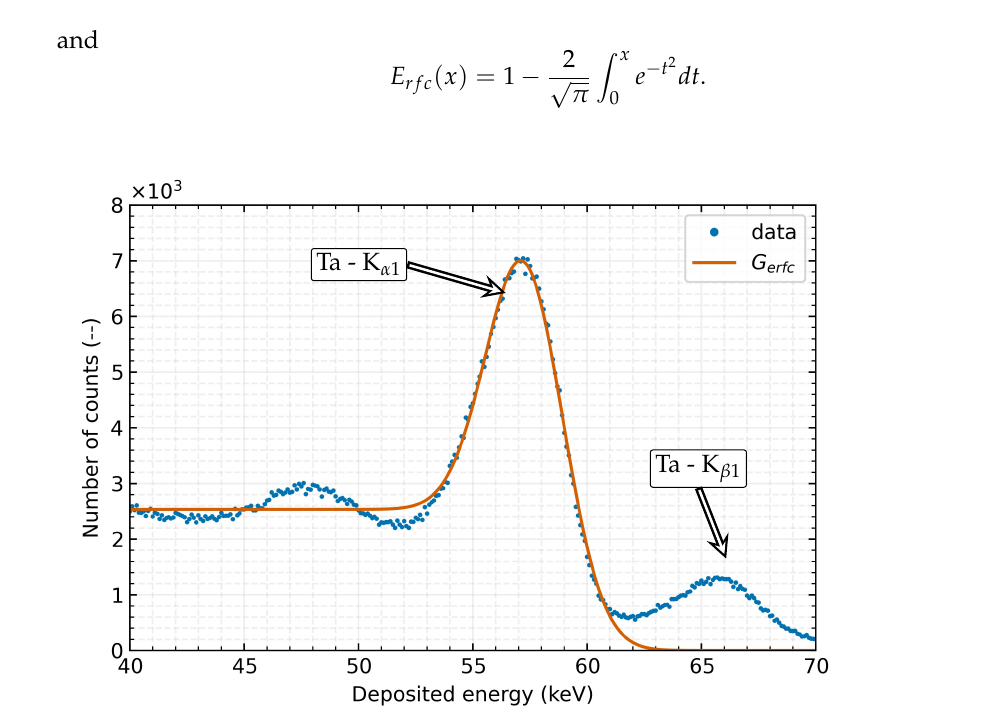
Figure 3. Measured spectral peak generated by the X-ray fluorescence of a tantalum target. The measured data (blue line), together with the result of the applied G erfc function fit on the Ta-K α 1 XRF peak (orange line), are shown on the graph. The TPX3 detector with a 500µm Si detection layer was stabilised at 30°C throughout the